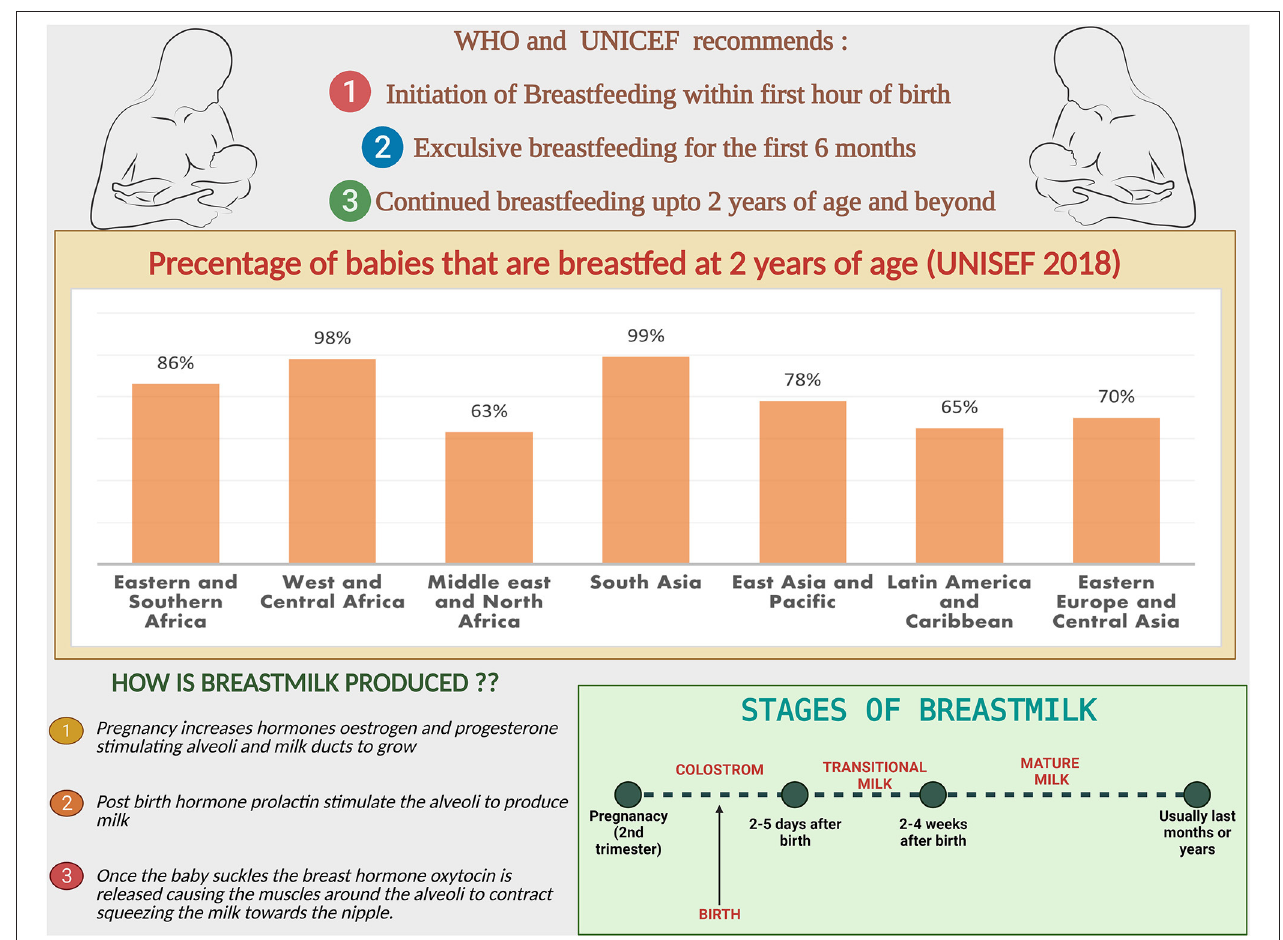
FIGURE 1 | Breastfeeding facts and figures: the recommendations from WHO and UNICEF, comparison of the percentage of babies breastfed at 2 years region wise. Steps and stages of breastmilk production.